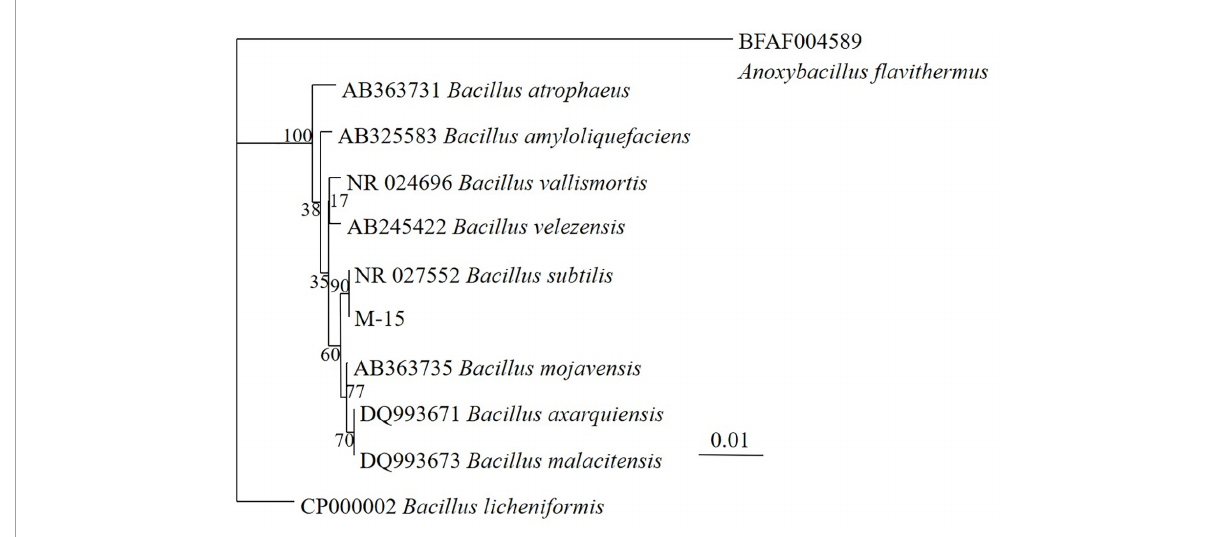
FIGURE3 Neighbor-joining tree based on 16S rDNA sequences showing relationship between the tested bacterium strain M-15 and related strains.